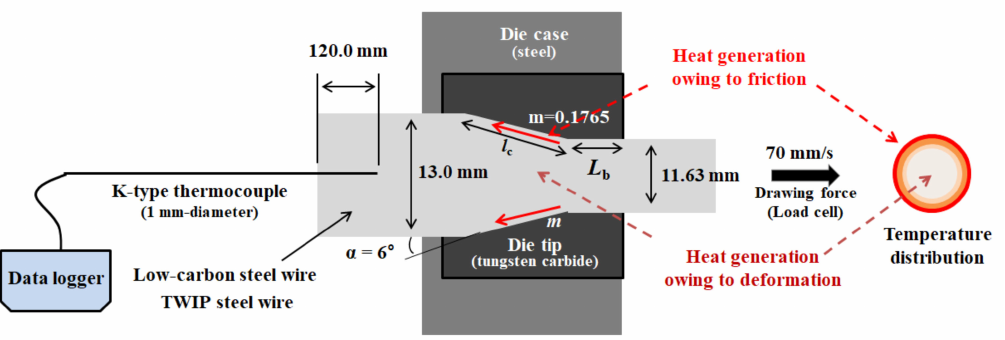
Figure 1. Schematic description of process conditions used in this wire drawing